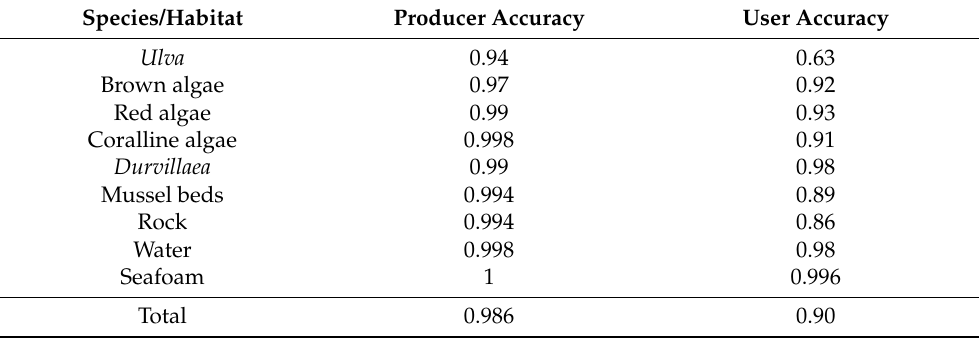
Table 2. Producer and user accuracy of support vector machine habitat classifications as compared to in situ validation